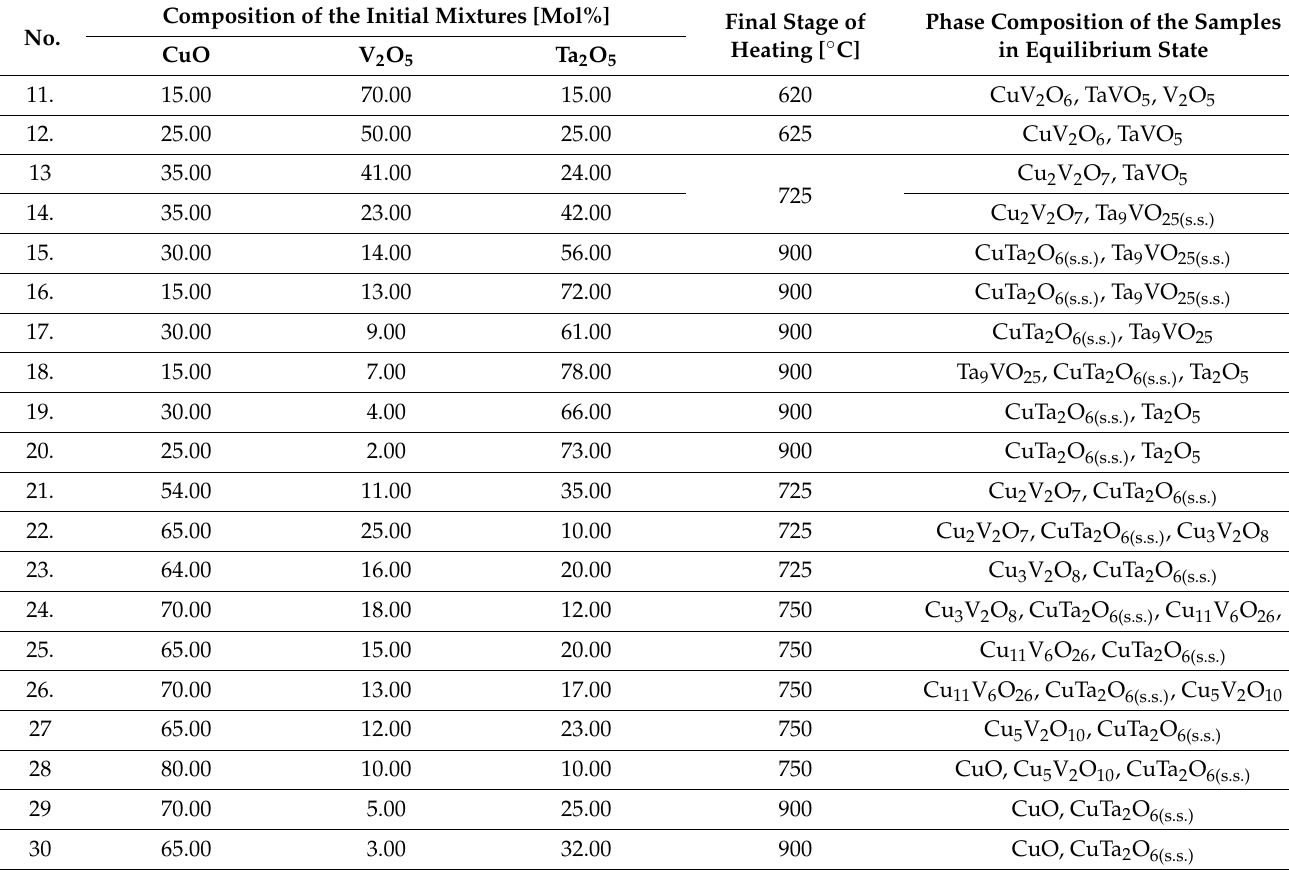
Table 4. The compositions of the initial mixtures of oxides and the results of the XRD analysis of the samples after the last heating